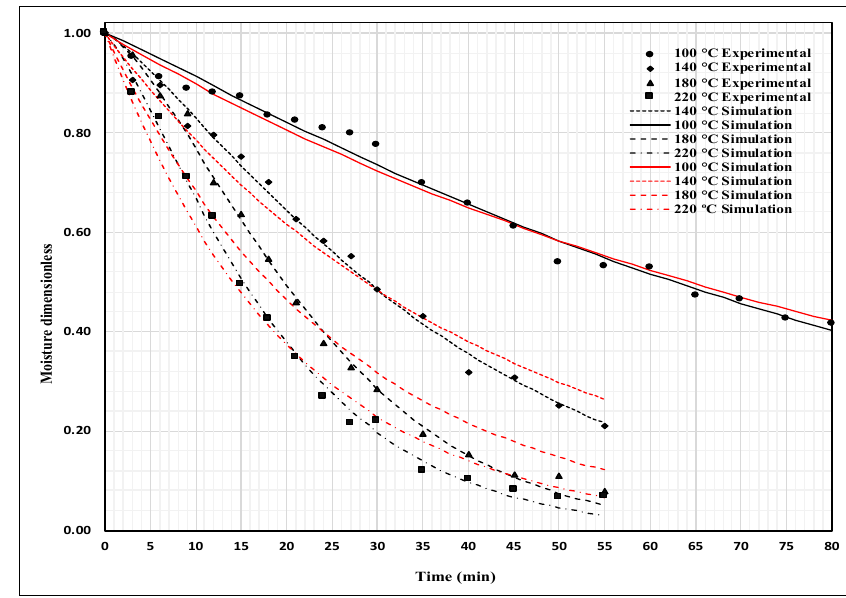
Figure 1. Moisture curves during roasting. Experimental data of moisture content (symbols) and simulation (red continuous lines) kinetics applying the pseudo-first order equation and (black continuous lines) Page model.